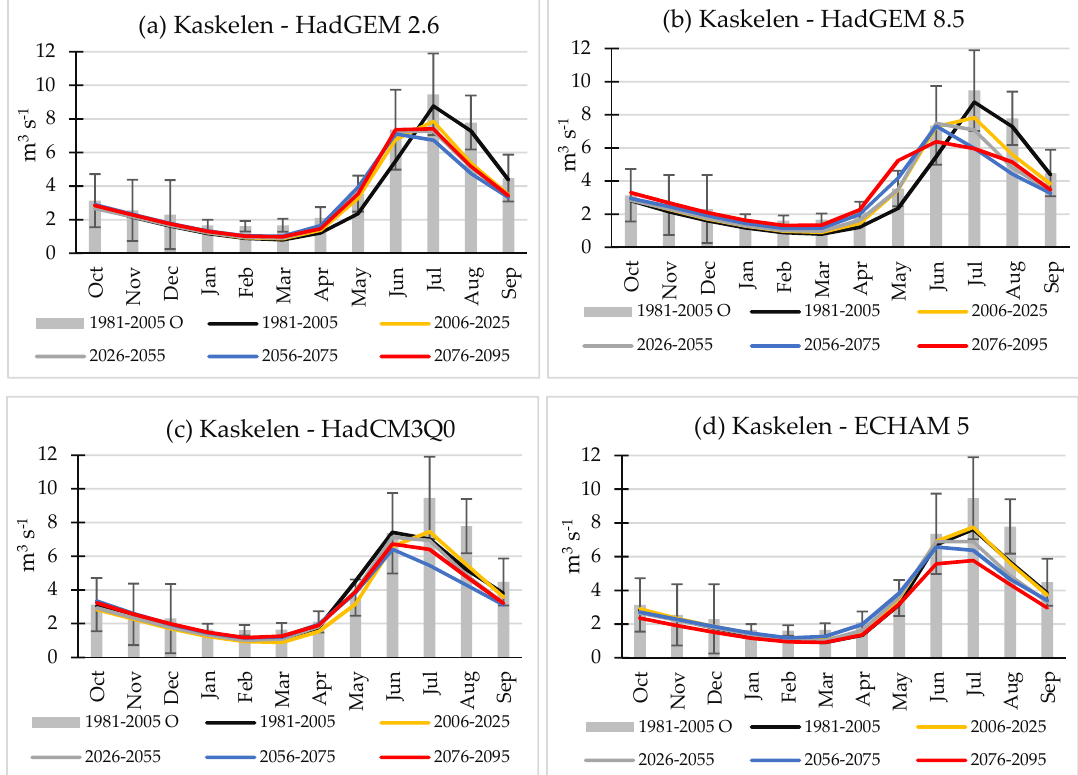
Figure 14. As in Figure 12 but for the Talgar. Note that observational data refer to the 1983–1995 period.